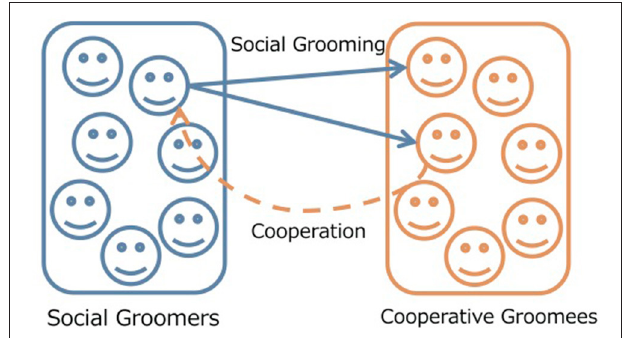
FIGURE 1 | Concept of our model. Social groomers interact with cooperative groomees depending on their social grooming strategies. Cooperative groomees cooperate with social groomers who are top R c on the strengths of social relationships. Groomer strategies evolve based on their fitness which is the amount of cooperation from